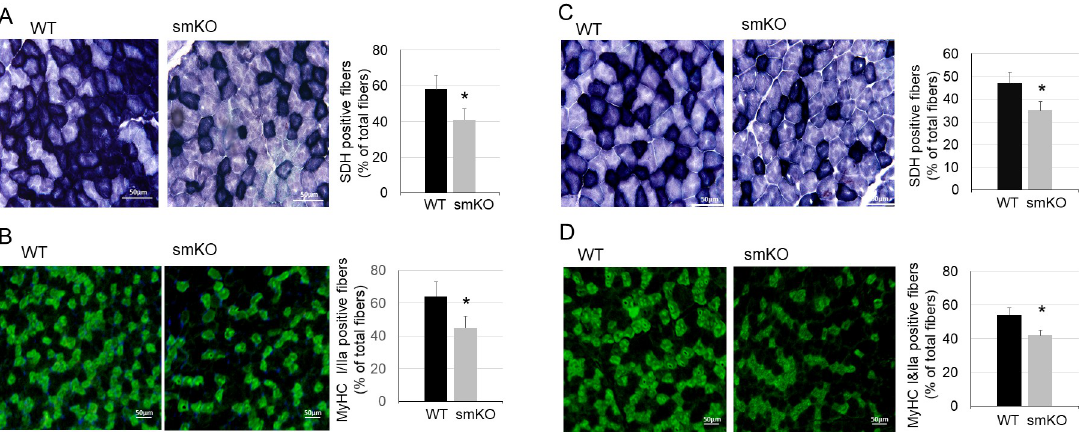
Fig 3. UCHL1 smKO reduces muscle oxidative activity. A-B : Representative images and quantifications of SDH staining (A) and type I/IIa MyHC fiber immunofluorescent staining (B) of soleus from WT and UCHL1 smKO mice. C-D: Representative images and quantifications SDH staining (C) and type I/IIa MyHC fiber immunofluorescent staining (D) of gastrocnemius from WT and UCHL1 smKO mice. The quantifications were presented as percentages of positive fibers vs total fibers in a selected area. � P < 0.05 vs WT.